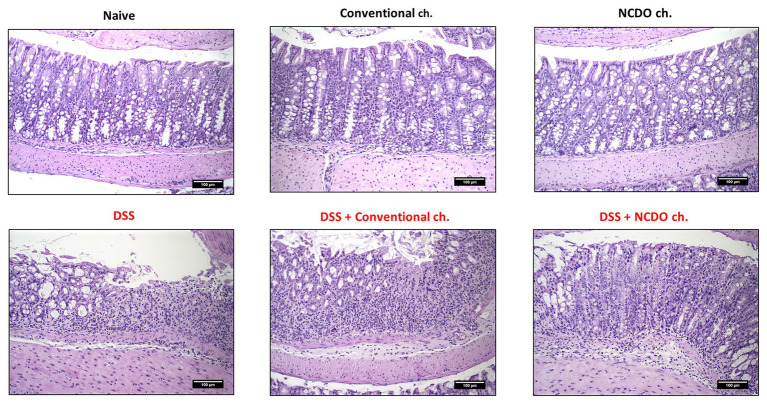
Effect of probiotic cheese administration on the dextran sodium sulfate (DSS)-induced histopathological damages. Representative H&E staining of colon mucosa sections. Image acquisition was done with a 20× magnification objective. Scale bar = 100 μm (n = 6).